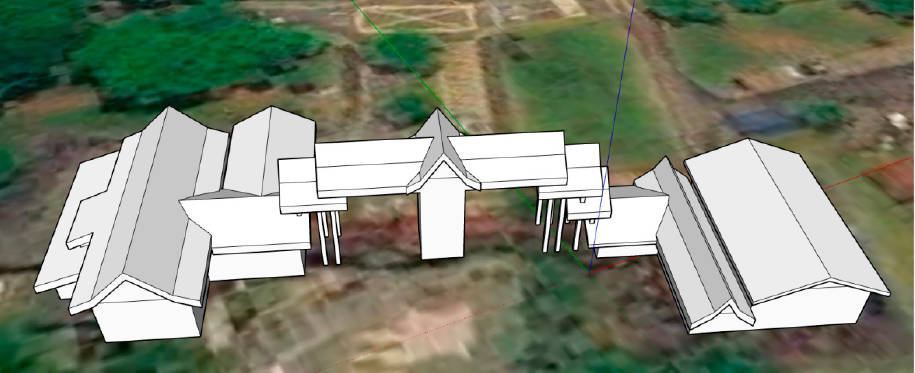
Figure 6. 3D model of building constructed in SketchUp.